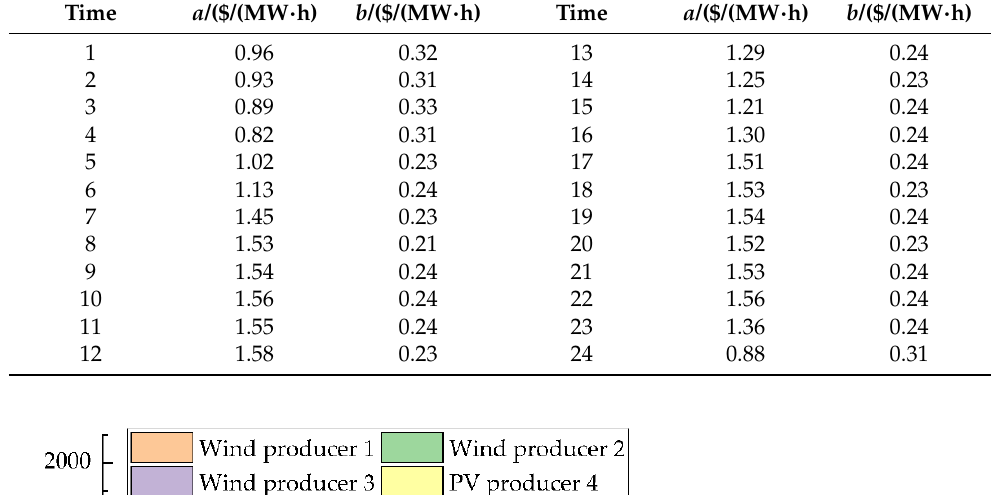
Table 2. Quotation factor for wind producer 1.